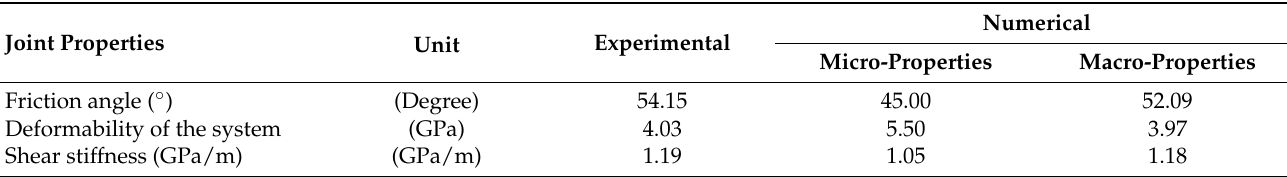
Table 3. Experimental and numerical mechanical properties of